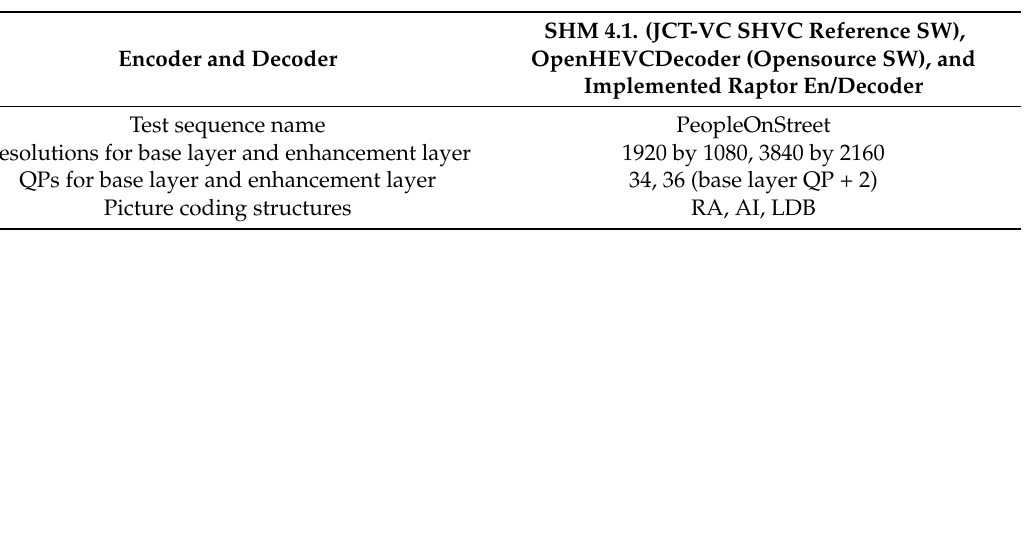
Table 1. Experimental environments. QPs, quantization parameters; RA, random access; AI, all intra; LDB, low-delay B.